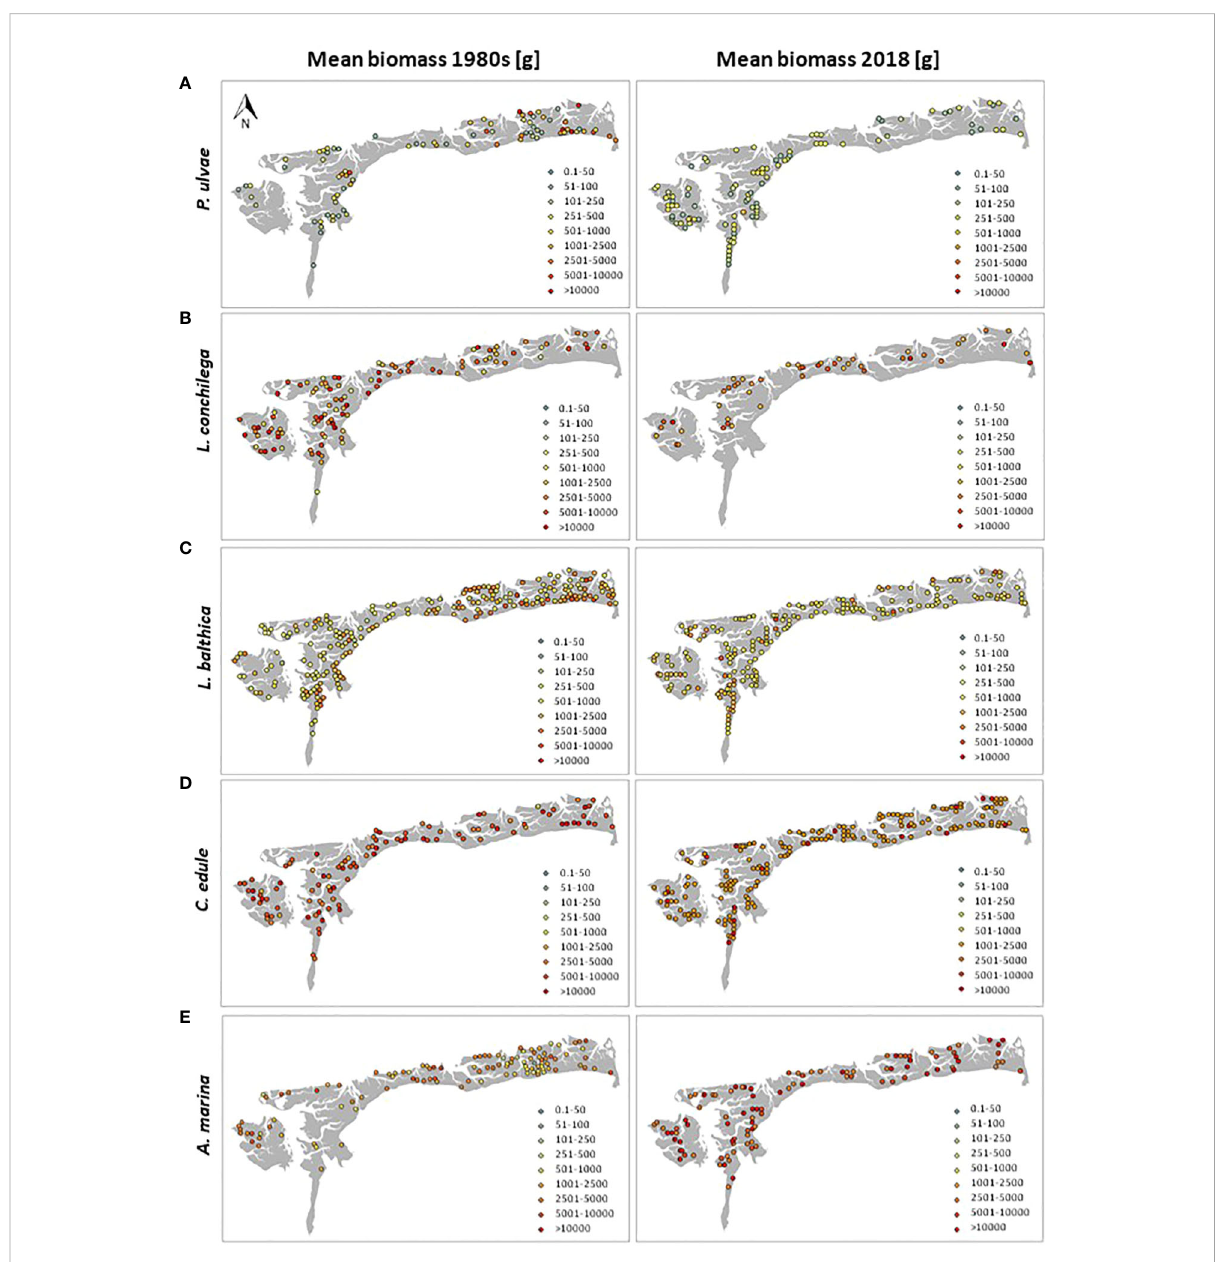
FIGURE 7 Overview of the spatial distribution of 5 dominant species showing most signi fi cant biomass decreases (A – C) , relatively stable biomass (D) and biomass increases (E) in the East-Frisian Wadden Sea